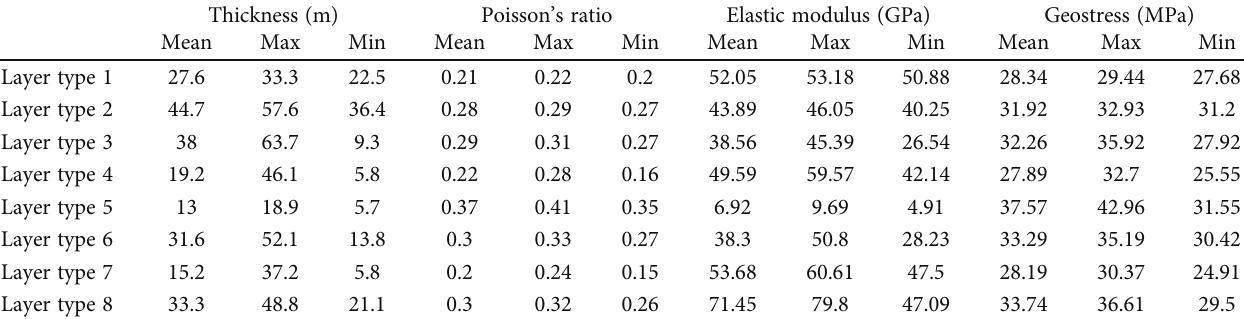
Table 2: The mean value and variation range of the geological parameters in di ff erent layer types. Thickness (m) Poisson ’ s ratio Elastic modulus (GPa) Geostress (MPa) Mean Max